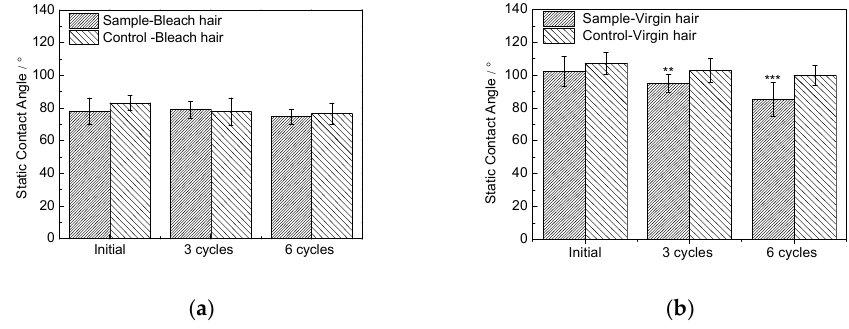
Figure 4. The hydrophilic properties of ( a ) bleach hair and ( b ) virgin hair sample (exposed) and control (unexposed, washed by solvents) after pre-treatment, and the third and sixth treatments. Note: comparison to the control group, * p < 0.01, *** p < 0.001.